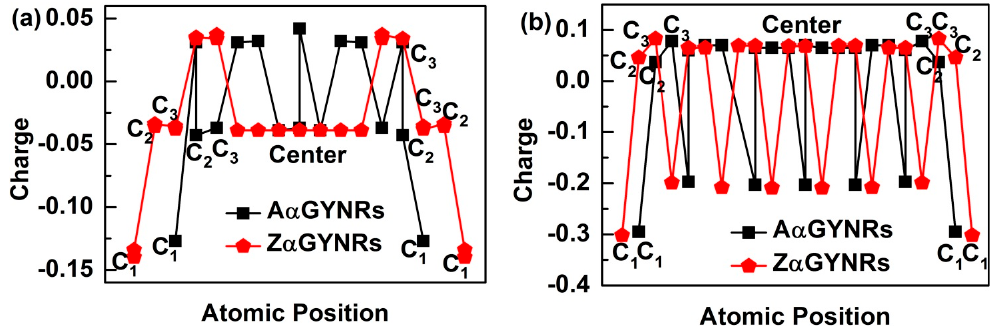
Figure 6. The charge entrapment of graphyne nanoribbons (GYNRs) with ( a ) armchair- and zigzag-edged α -GYNRs; ( b ) armchair and zigzag-edged β -GYNRs.